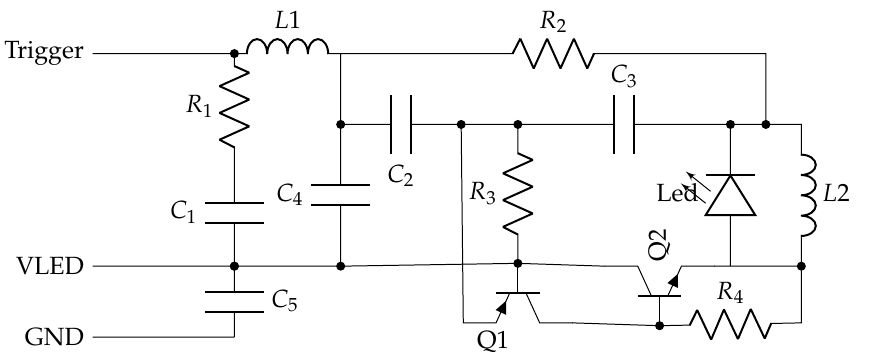
Figure 3. Pulser circuit. The values of the components are: L1 = L2 = 100 µH; C1 = 100 nF; C2 = 47 pF; C3 = 100 pF; C4 = 10 pF; C5 = 10 nF; R1 = 100 Ω ; R2 = 100 k Ω ; R3 = 2.2 k Ω ; and R4 = 10 k Ω